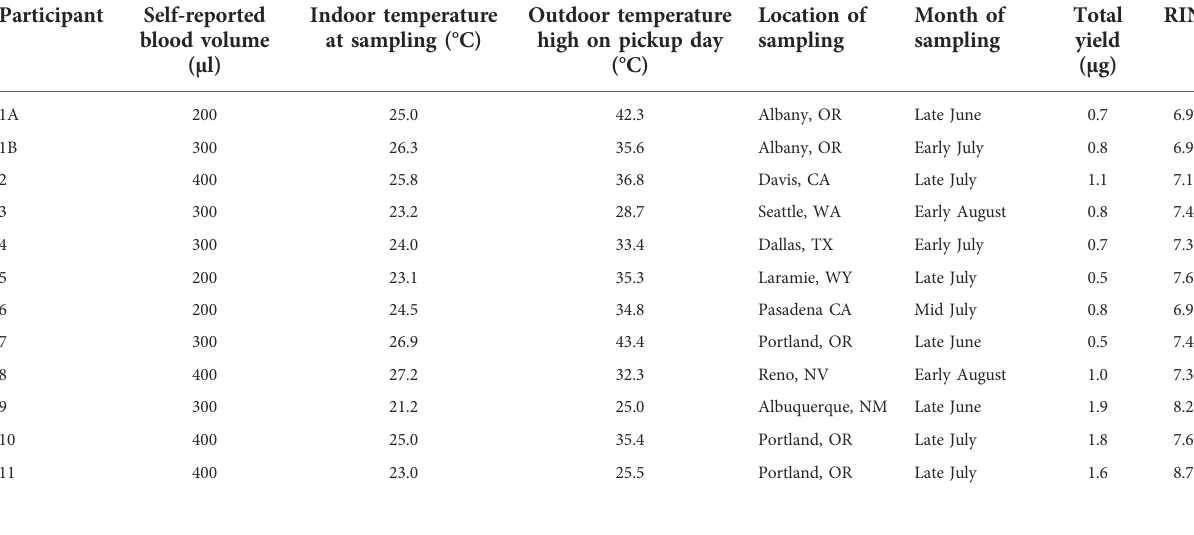
TABLE 1 Participant and sampling information for the Western and South Central USA pilot